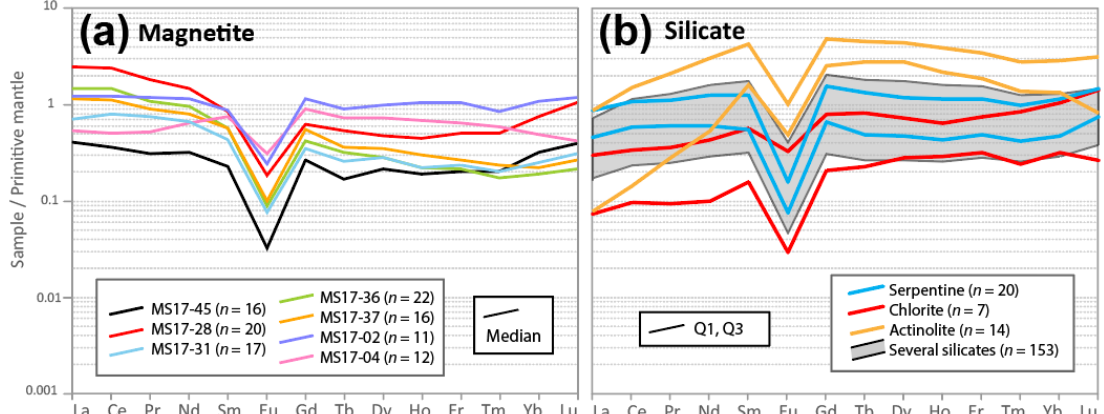
Figure 14. REE diagram normalized to the primitive mantle [42] for ( a ) magnetites and ( b ) silicates as analyzed by LA-ICP-MS.